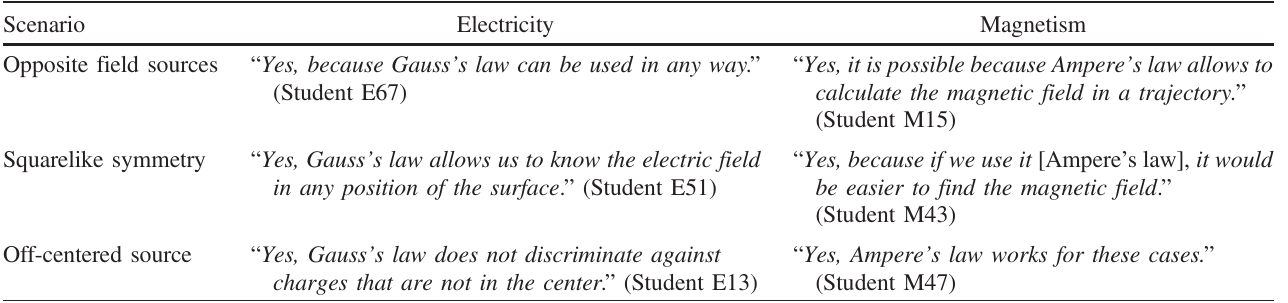
TABLE VI. Examples of students ’ reasoning in the category authority fallacy for each scenario.